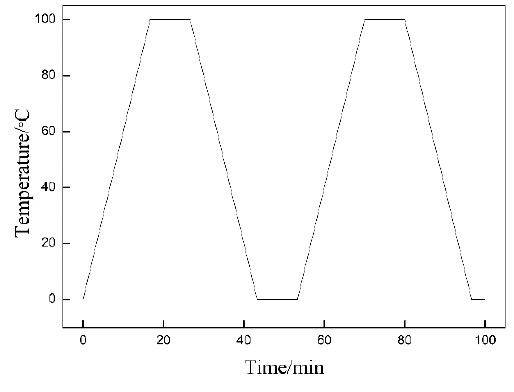
Figure 2. Thermal Figure 2. Thermal cycles.